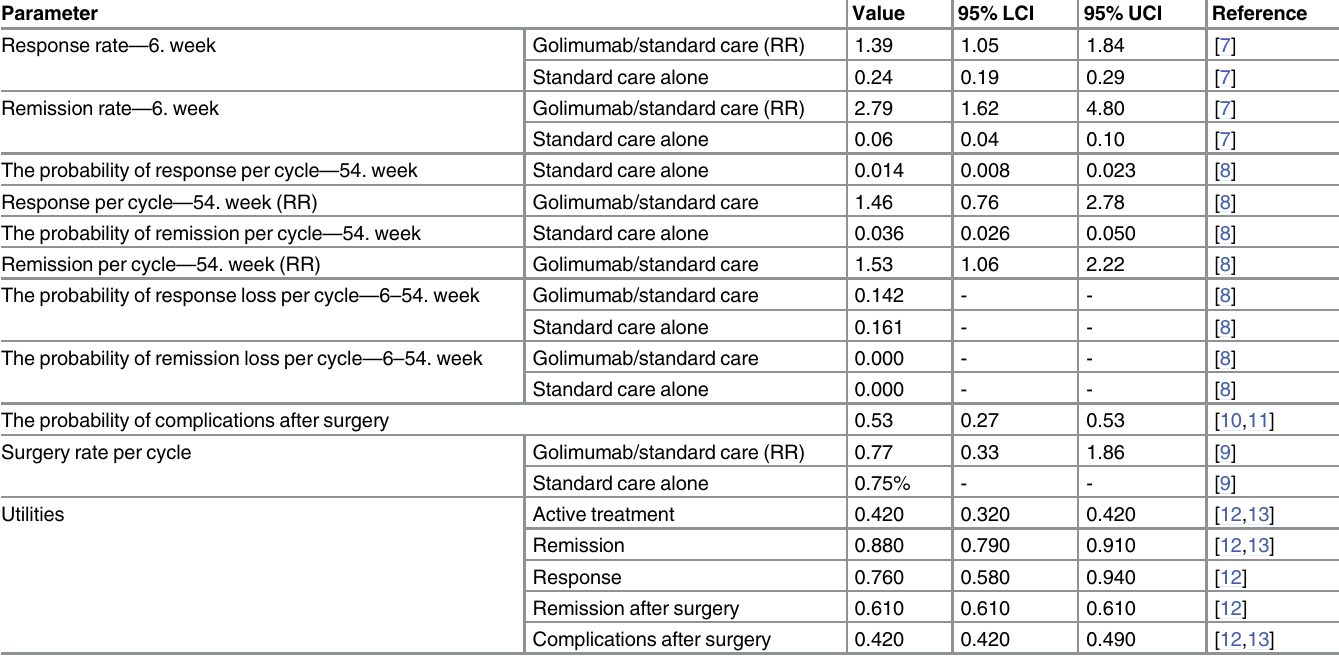
meet at least one of the following criteria: (1) had an inadequate response to conventional Table 1. Clinical inputs and utilities used in the